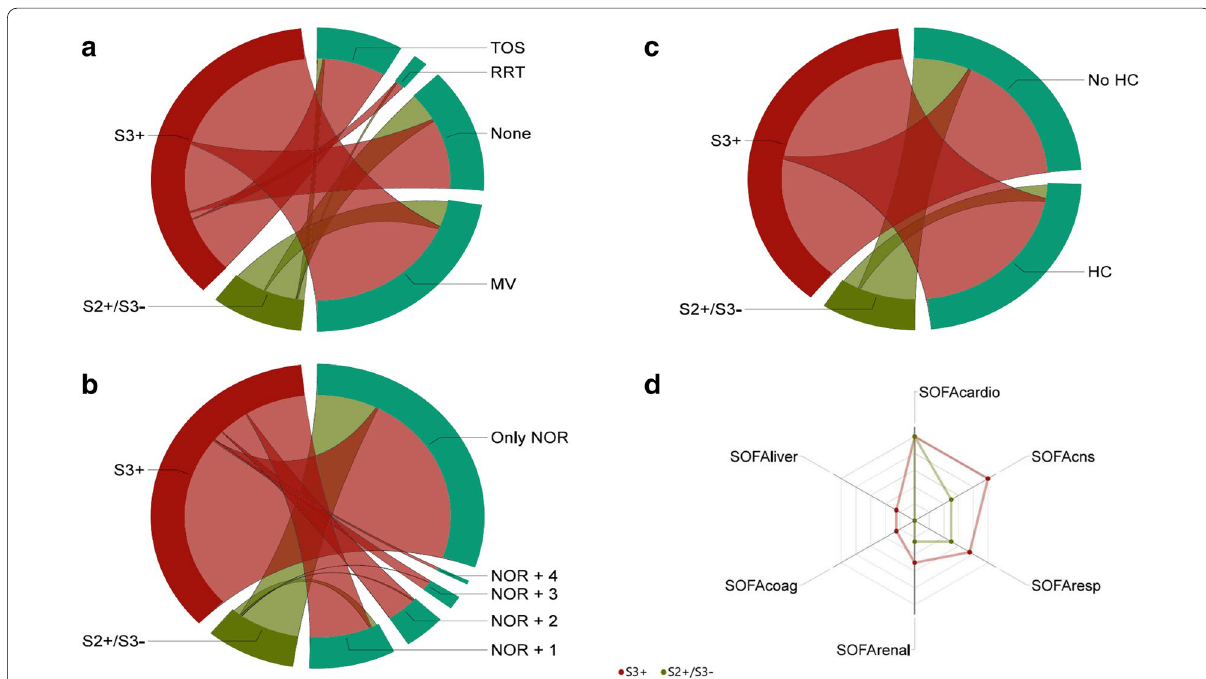
Fig. 2 Differences in organ support and organ dysfunction variables between the S3 the need for organ support—on top of vasopressor therapy—in S3 mechanical ventilation, TOS: triple organ support—combination of vasopressor therapy, MV and RRT. b Chord diagram representing administration of hydrocortisone (HC) in septic shock. c Chord diagram representing the number of adjuvant vasopressor or inotropic agents on top of norepinephrine (NOR). Examined medications are epinephrine, vasopressin, dobutamine and milrinone. d Radar plot of the SOFA subscores: cardiac (SOFAcardio), neurological (SOFAcns), respiratory (SOFAresp), renal (SOFArenal), coagulation (SOFAcoag) and hepatic (SOFAliver)